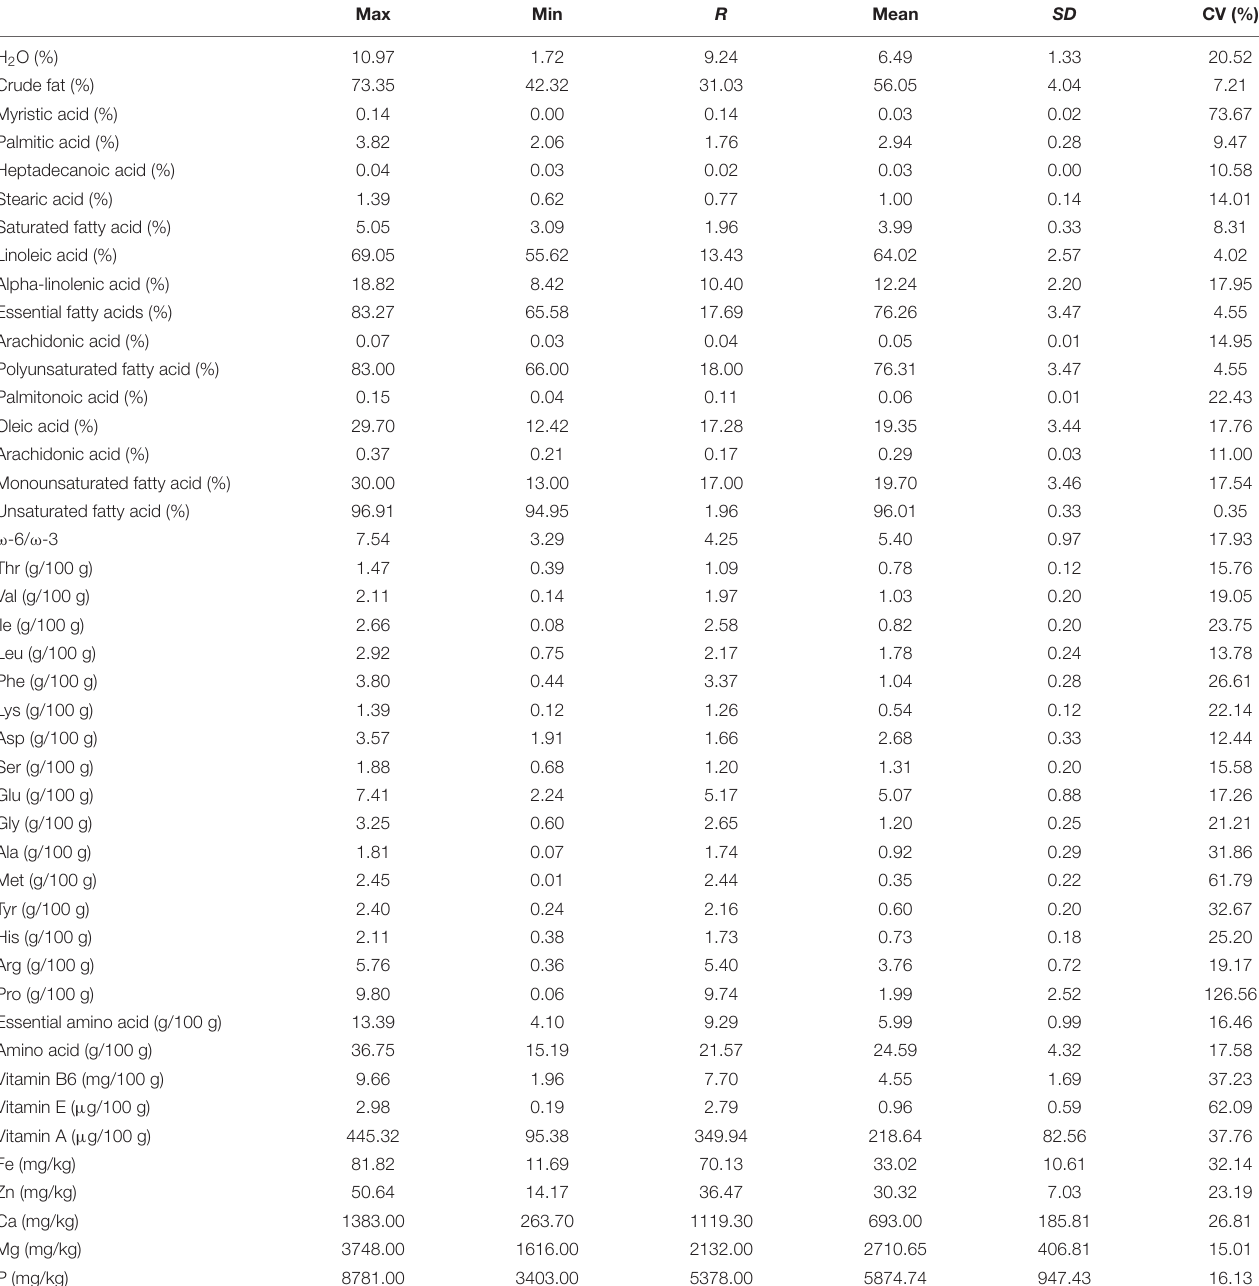
TABLE 3 | Nutritional composition analysis of J. mandshurica